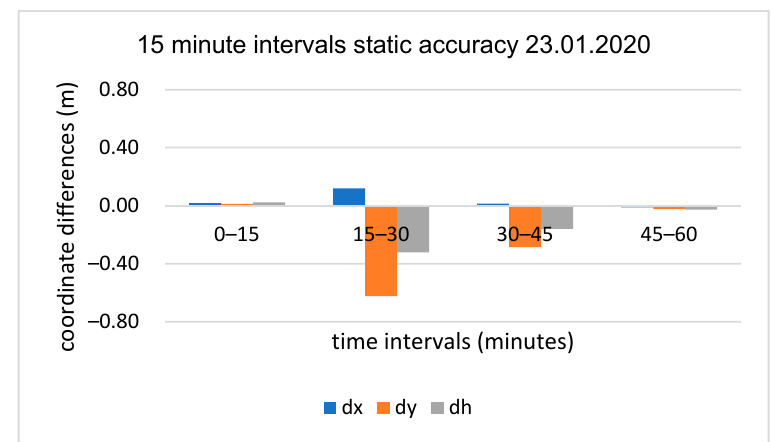
Figure 17. 10 min sub-session positioning results for the third test, baseline OPNT–P30Pro (4 km).